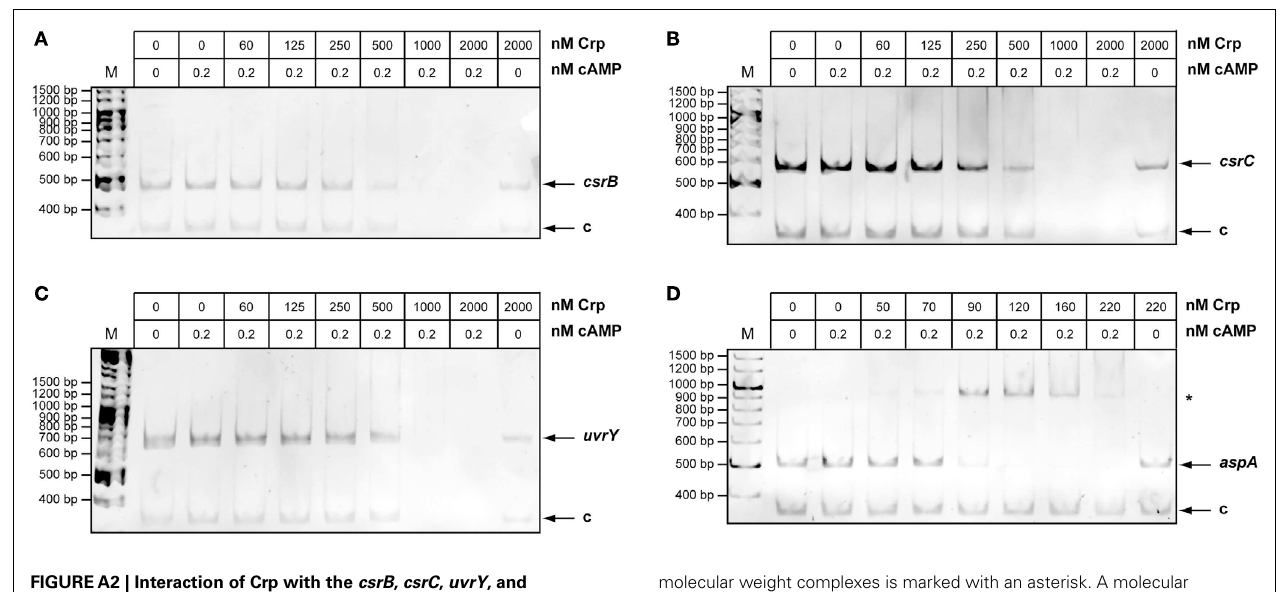
FIGUREA2 | Interaction of Crp with the csrB , csrC , uvrY , and aspA regulatory regions. The DNA promoter fragments were incubated with increasing concentrations of Crp and 0.2mM cAMP. A sample with the highest protein concentration without cAMP was used a snegative control (right lane).The Crp-DNA complexes were separated on a 4% polyacrylamide gel.The position of specific higher